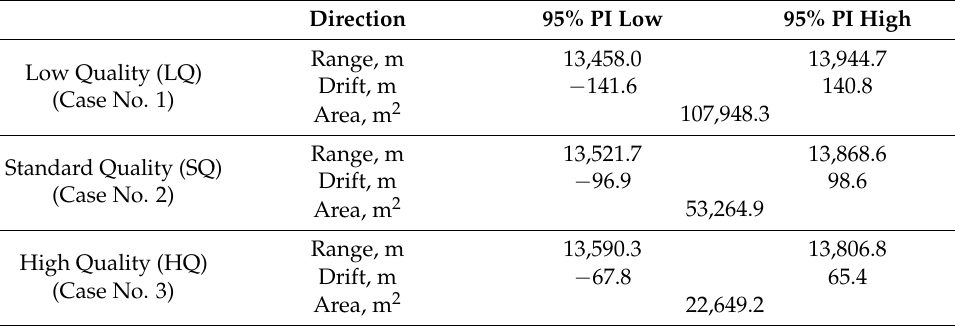
Table 3. Prediction intervals of the single impact point, various quality